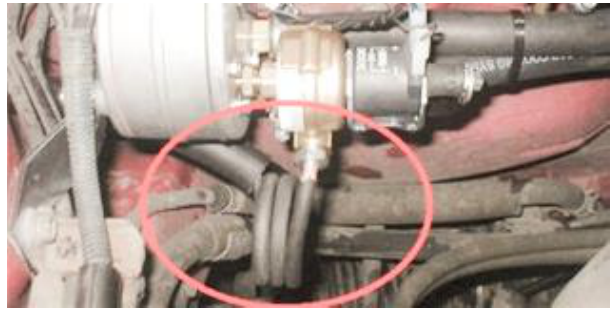
Fig. 8. The method of connecting the evaporator with a rigid copper LPG